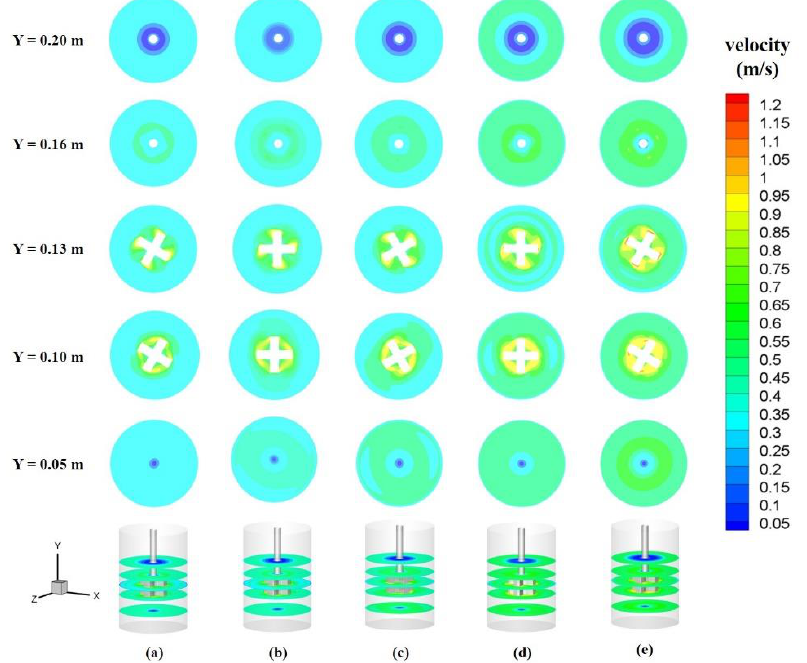
Figure 9. The velocity distribution of different levels at IRS of ( a ) 180 rpm, ( b ) 200 rpm, ( c ) 220 rpm, ( d ) 240 rpm and ( e ) 260 rpm.